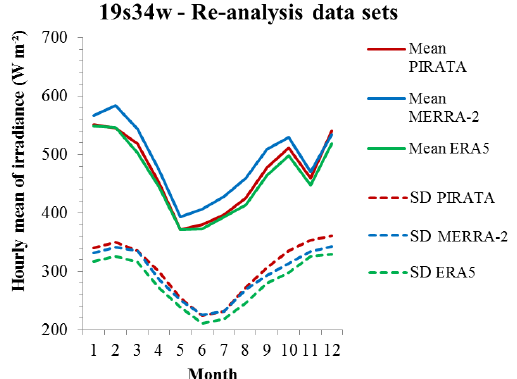
Figure D6. Monthly means (solid lines) and standard deviations (dotted lines) of hourly DSIS, in Wm − 2 , from PIRATA measurements (red) and data sets (MERRA-2: blue, ERA5: green) at 19 ◦ S, 34 ◦ W. A difference between red line (measurements) and coloured line (data set) for a given month denotes a systematic error for this month: underestimation if the coloured line is below the red line, overestimation otherwise. For a given month, a coloured dotted line above the red one means that the data set produces too much variability for this month; in the opposite case, the data set does not contain enough